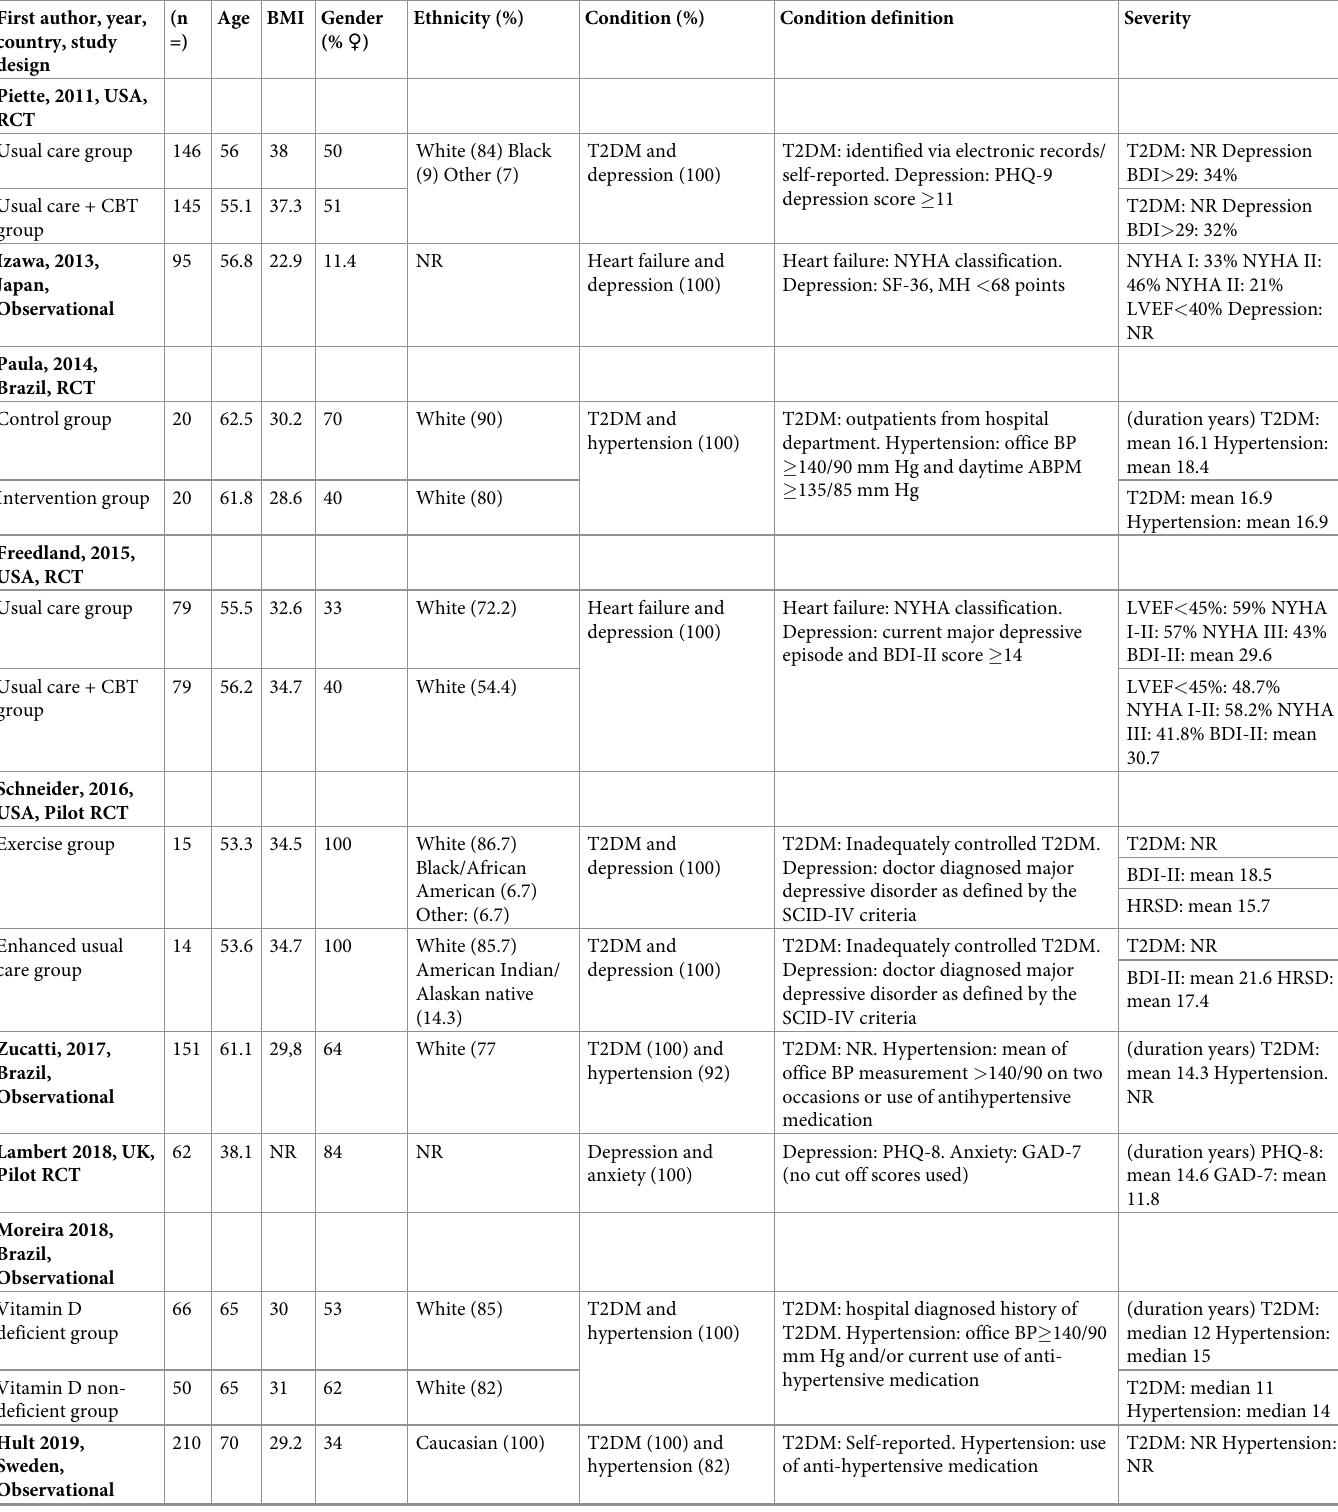
Table 1. Conditions and selected demographic variables in the included